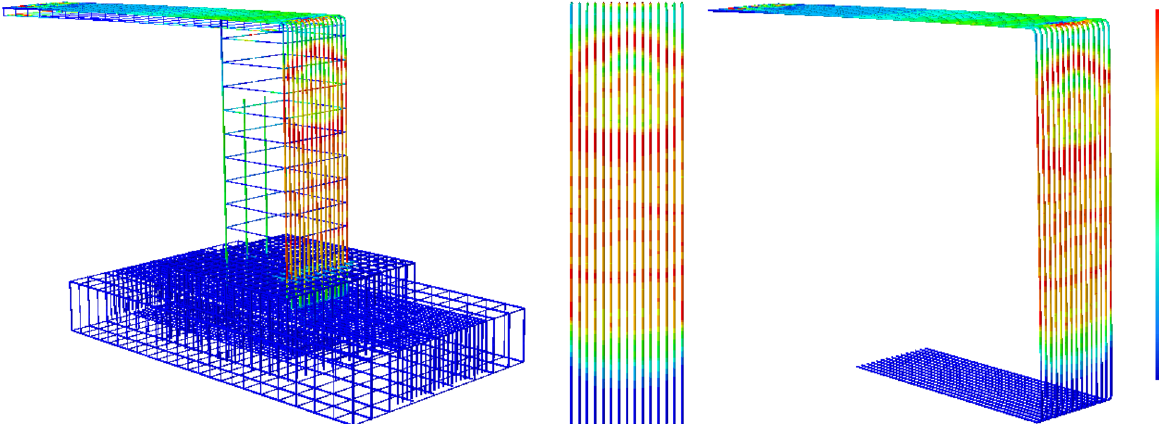
Figure 12. Reinforcement stress intensity.